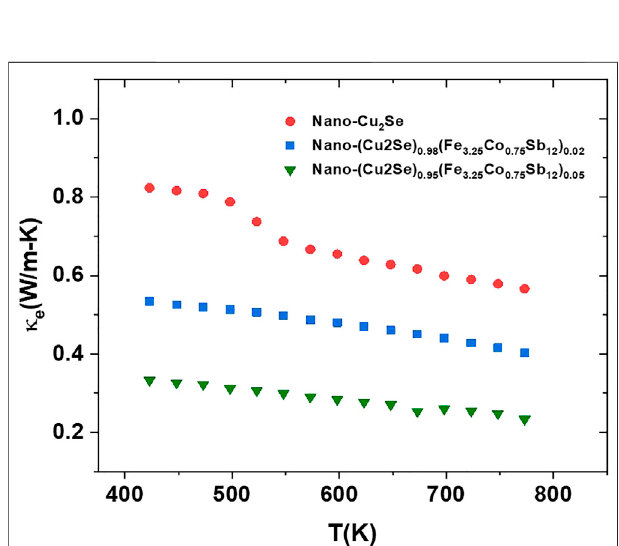
FIGURE 8 | The heat capacity, Cp, vs. temperature for nano-Cu (nano-Cu 2 Se) 0.95 (nano-FeCoSb) 0.05 and (nano-Cu 2 Se) 0.98 (nano-FeCoSb) 0.02 samples.